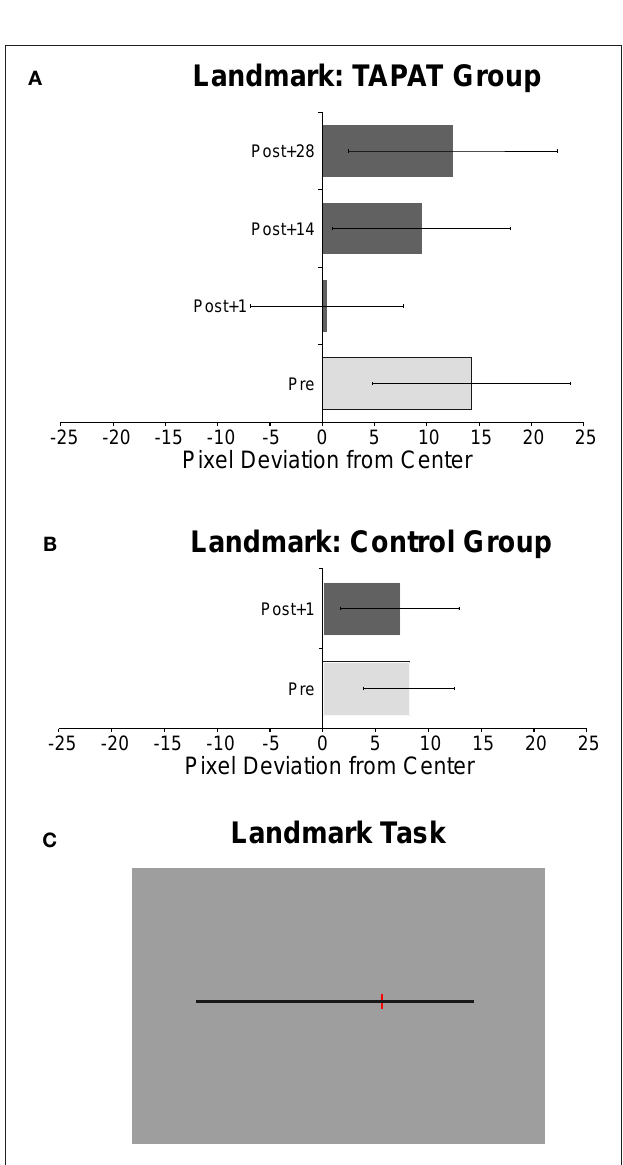
Figure 6 | group landmark results for TAPAT (A) and Control (B) groups. The pixel deviation from center measures patients’ subjective perception of the center of the black line compared to the actual center (left is negative, right is positive). Error bars represent the standard error of the mean. (C) is an example of a landmark